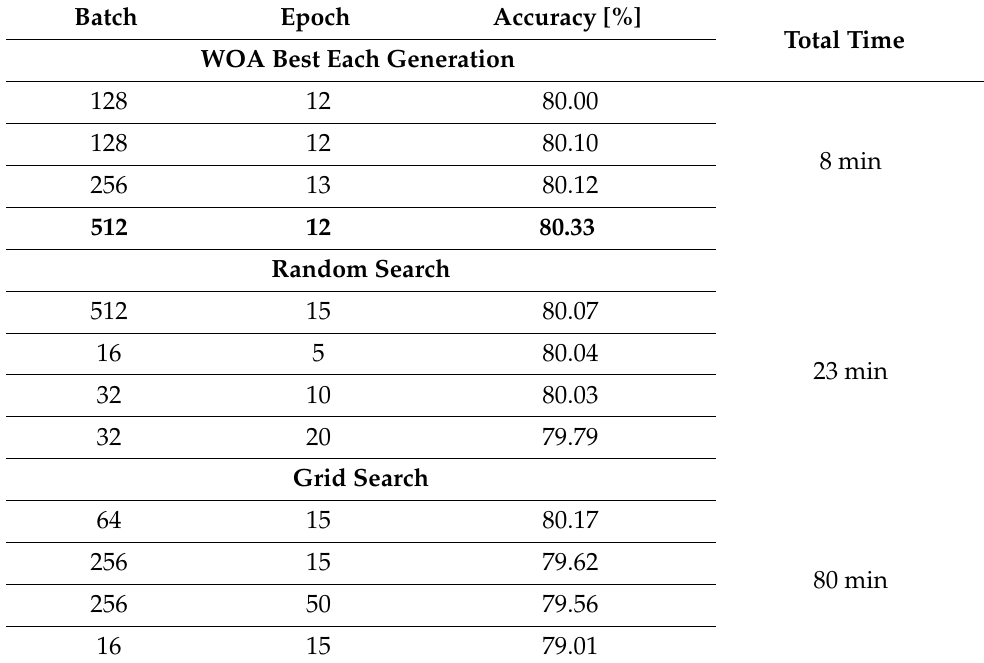
Table 3. Reuters, epoch (0–50), discrete batch, Adam optimiser.